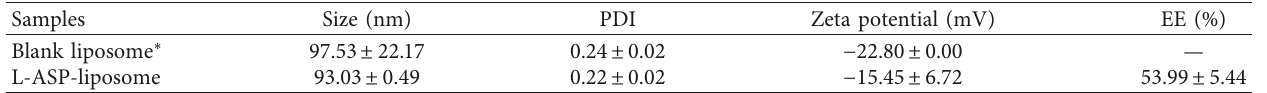
Figure 1: Molecular weight analysis of purified L-ASP obtained from P. carotovorum using SDS-PAGE on 12.5% gel of stained with coomassie blue; M-Fermentas ladder; 1-crude extract of L-ASP; 2-purified L-ASP. Table 2: Determined physiochemical characteristics of liposomes loaded